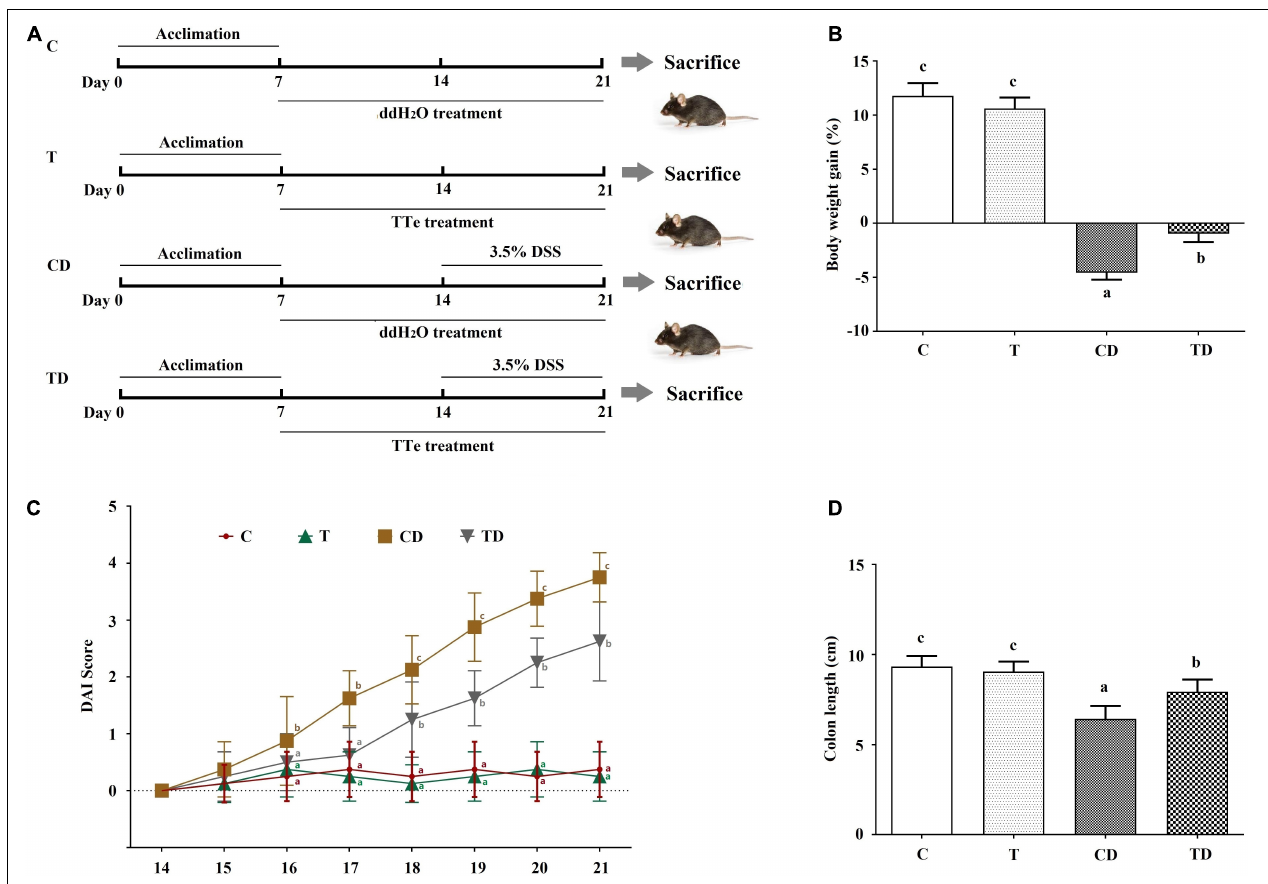
FIGURE 1 | Effect of Tibetan tea on the colon tissues of dextran sodium sulfate (DSS)-induced ulcerative colitis (UC) in mice. (A) Schema of the experimental design. (B) Body weight gain. (C) Disease Activity Index (DAI) scores during DSS treatment. (D) Colon length. Data were expressed as the mean ± SD. Lowercase letters a – c indicate significant differences in all treatment groups ( p < 0.05). C , control group ( n = 8); T , Tibetan tea group ( n = 8); CD, DSS model group ( n = 8); TD , Tibetan tea + DSS group ( n =